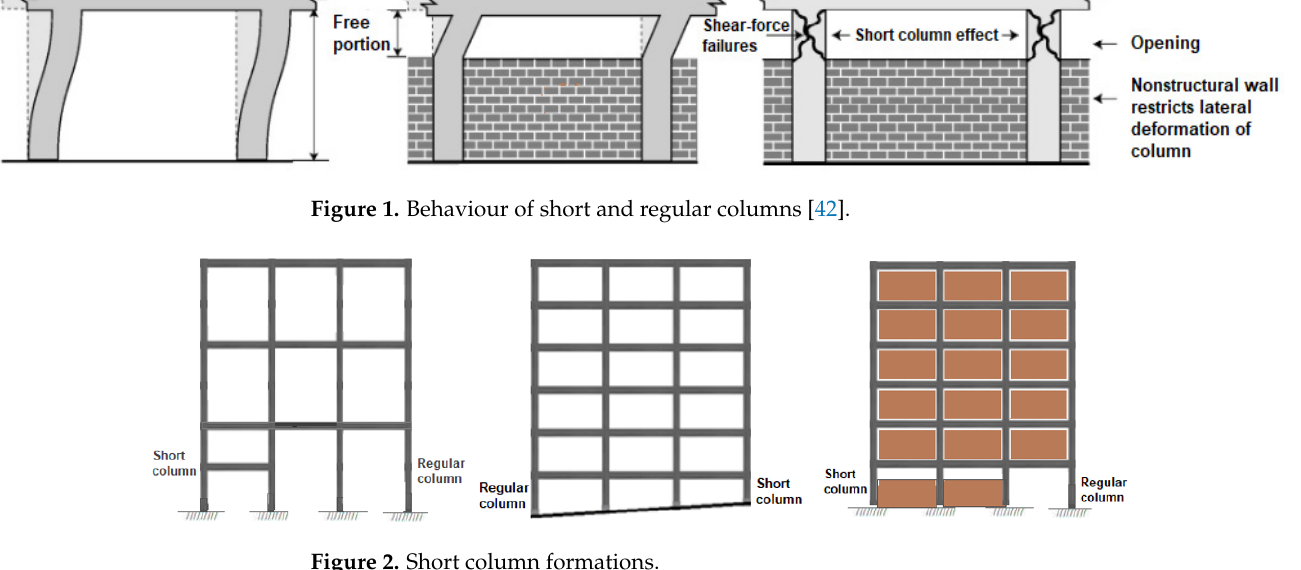
( c ) Figure 3. Short column damages: ( a )-24 January 2020 Elaz ı ğ earthquake [48], ( b )-25 January 1999 Armenia Colombia earthquake [49], ( c )-26 January 2001 (Bhuj) India earthquake [50]. 3. Performance-Based Assessment and Design Principles Following numerous destructive earthquakes worldwide, the significance of re- search, studies and earthquake prevention has recently increased. Due to the vulnerability of both rural and urban building stock, earthquake damages grow. The magnitude of the earthquakes and the poor structural characteristics increase the size of the damage. Know- ing the characteristics of buildings that will be adversely affected by their behaviour under earthquakes will reduce damage risk after earthquakes. Determining how well structures perform is the first step in minimizing earthquake damage. After earthquakes in Türkiye, particularly in the past 30 years, protecting existing buildings has become increasingly important. For RC structures already in existence, performance-based assessment proce- dures are frequently applied. A building’s susceptibility to earthquake damage is known as its seismic vulnerability. Seismic vulnerability relationships make an effort to forecast, for a variety of building classes, the severity and scope of damage at specific seismic de- mand levels [51]. Using the performance-based design and evaluation technique, it is feasible to calcu- late the quantities of damage levels caused by design ground motion inside the structural